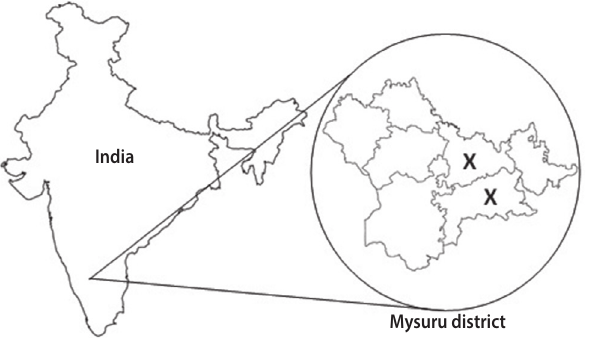
Figure 1. Map of India illustrating the site of sampling from which the Mysuru stUdies of Determinants of Health in Rural Adults (MU- DHRA) cohort was set up (X depicts the 2 rural sub-districts select- ed for the